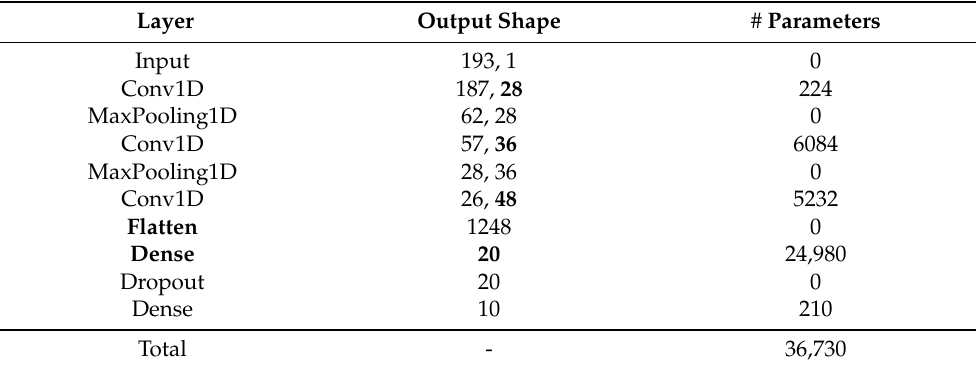
Table 2. Adjustments of our proposed CNN1D model. All modifications highlighted in bold for compatibility with hls4ml .